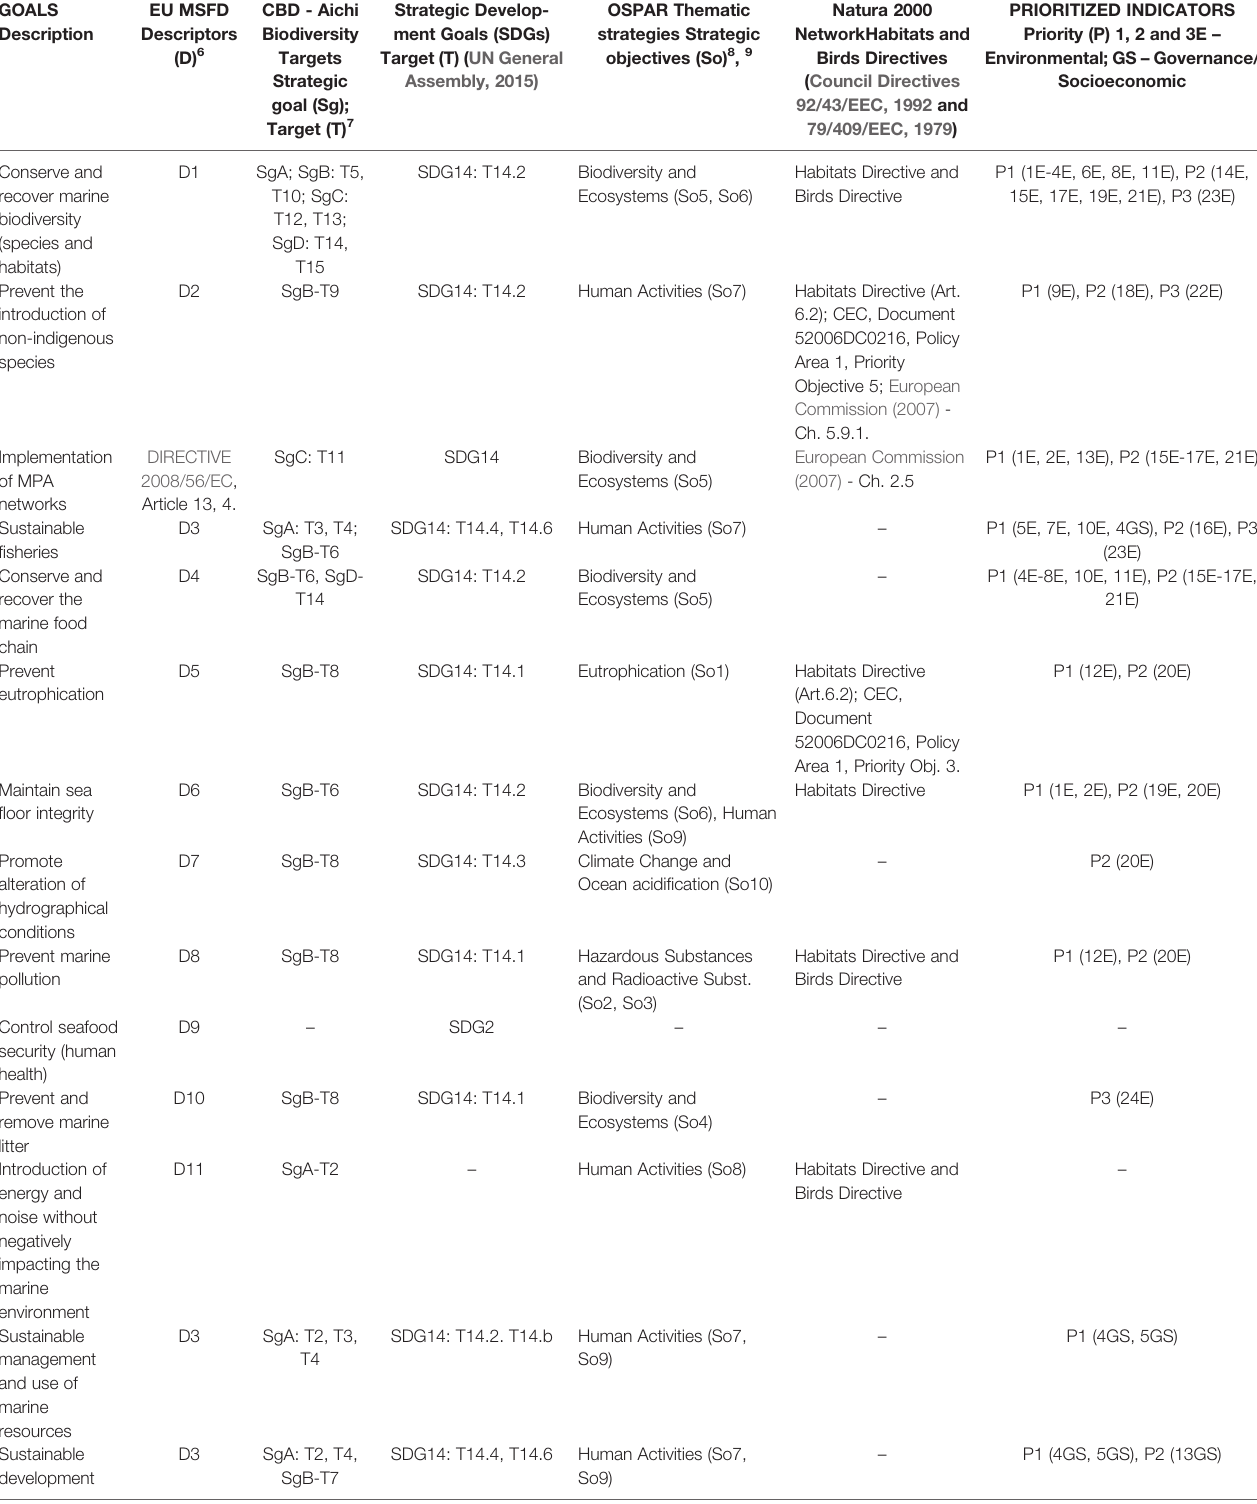
TABLE 4 | Correspondence between the prioritized MPA performance indicators and the goals of international instruments that are relevant for the MPAs context. GOALS